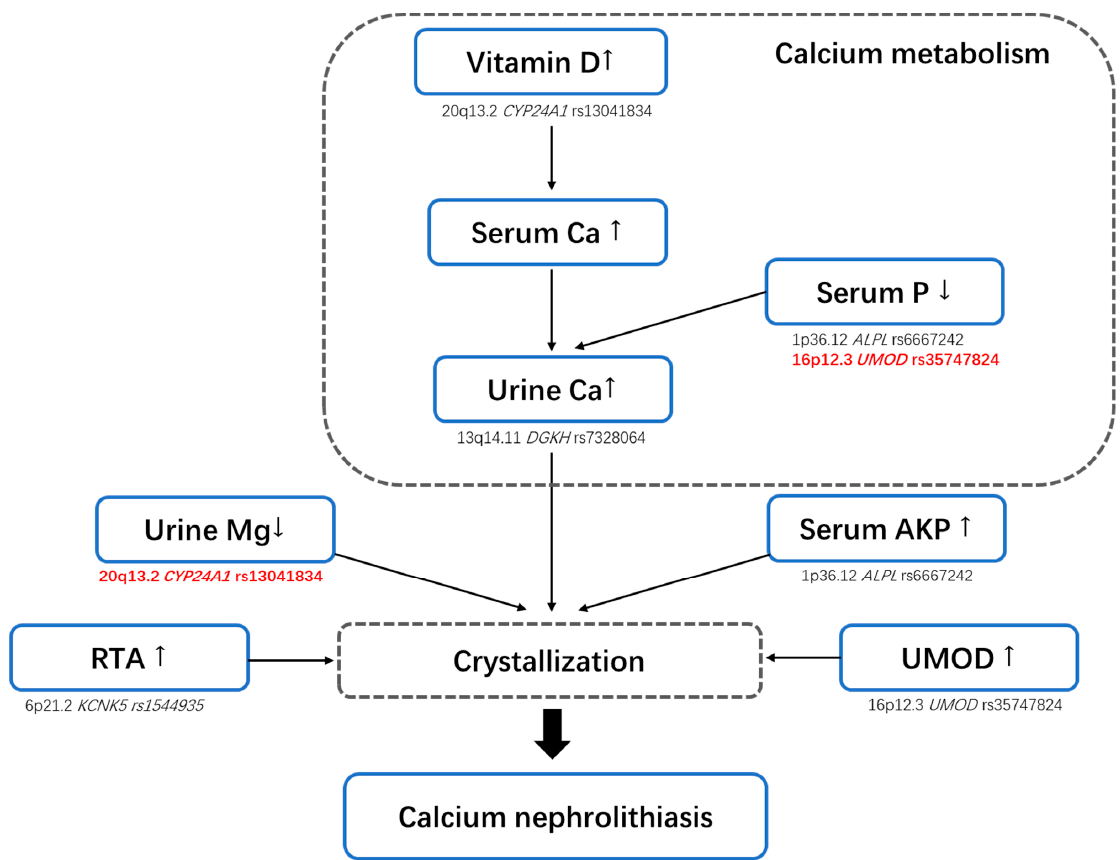
Figure 1. Schematic of the related components of the kidney calcium metabolism and crystallization pathways considered in the present study, including the putative effector genes and corresponding SNPs. The newly discovered correlations are shown in red.